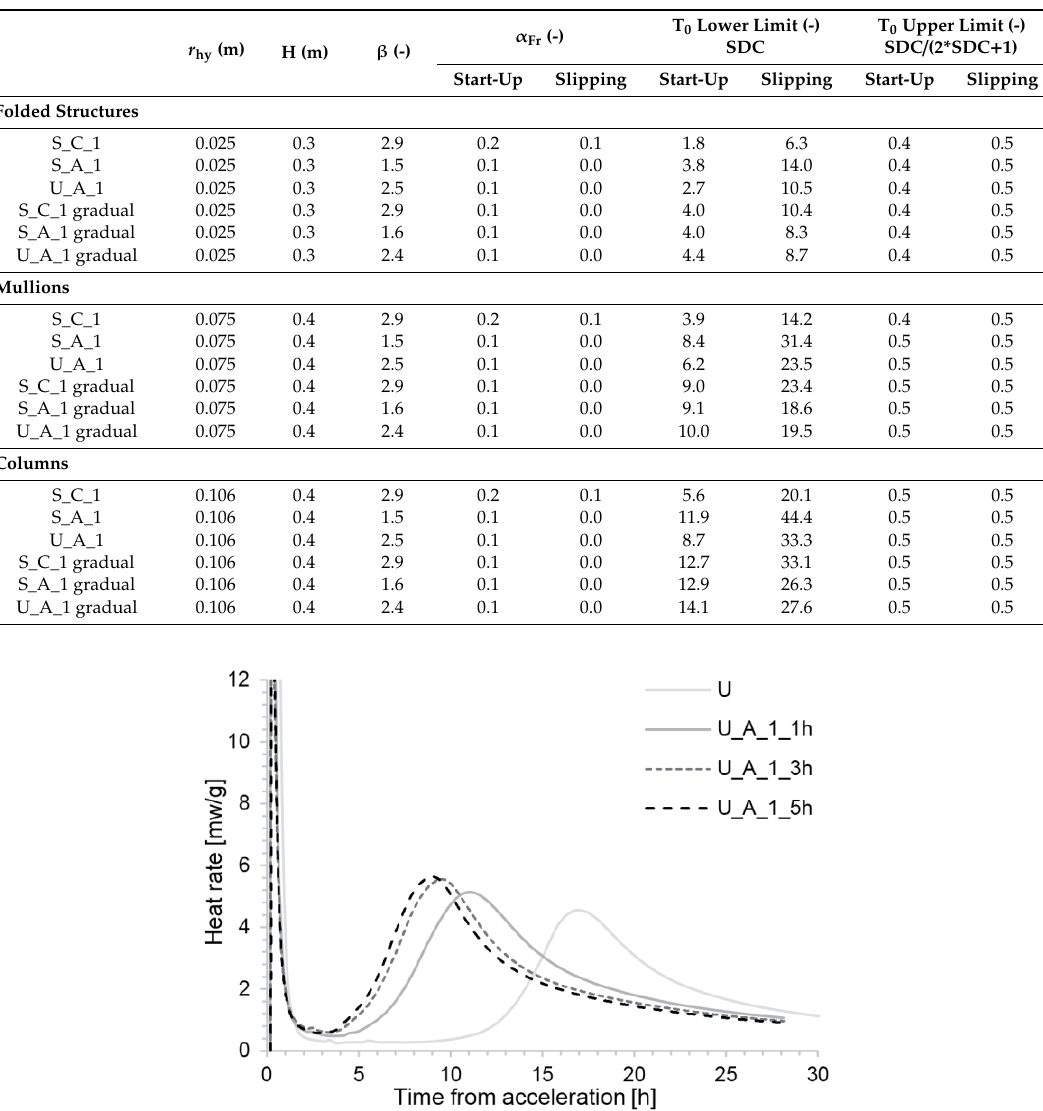
Folded Structures